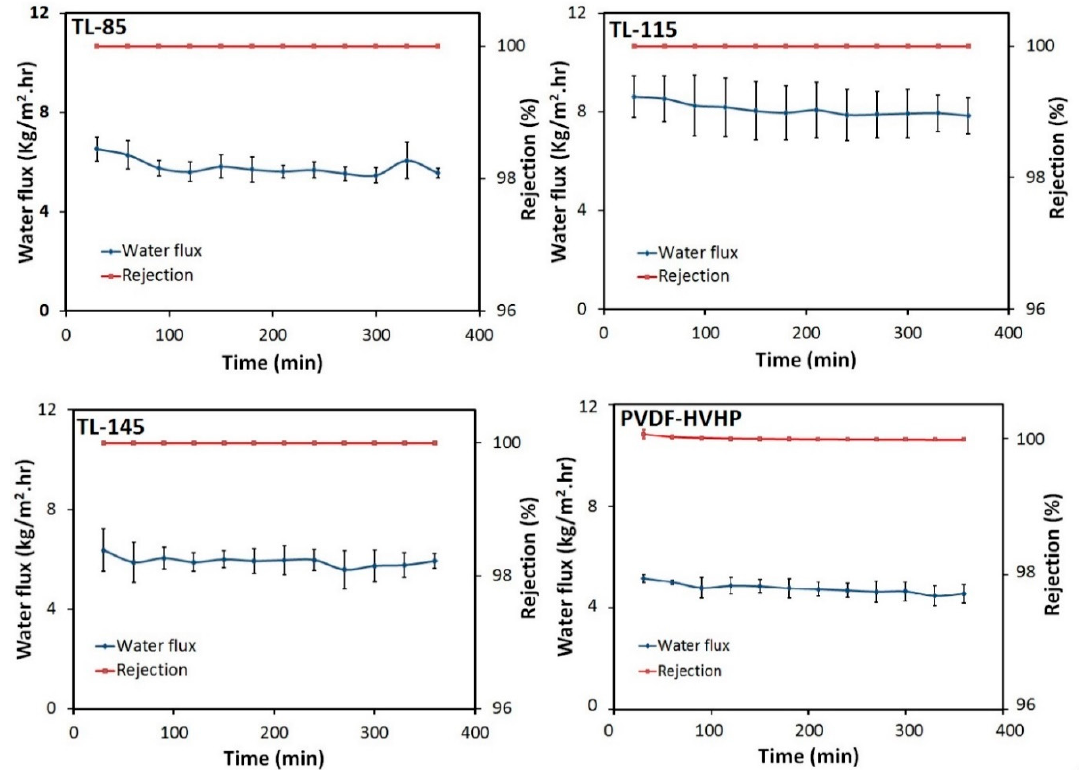
Figure 7. DCMD water flux and rejection for the prepared membranes with different thicknesses.